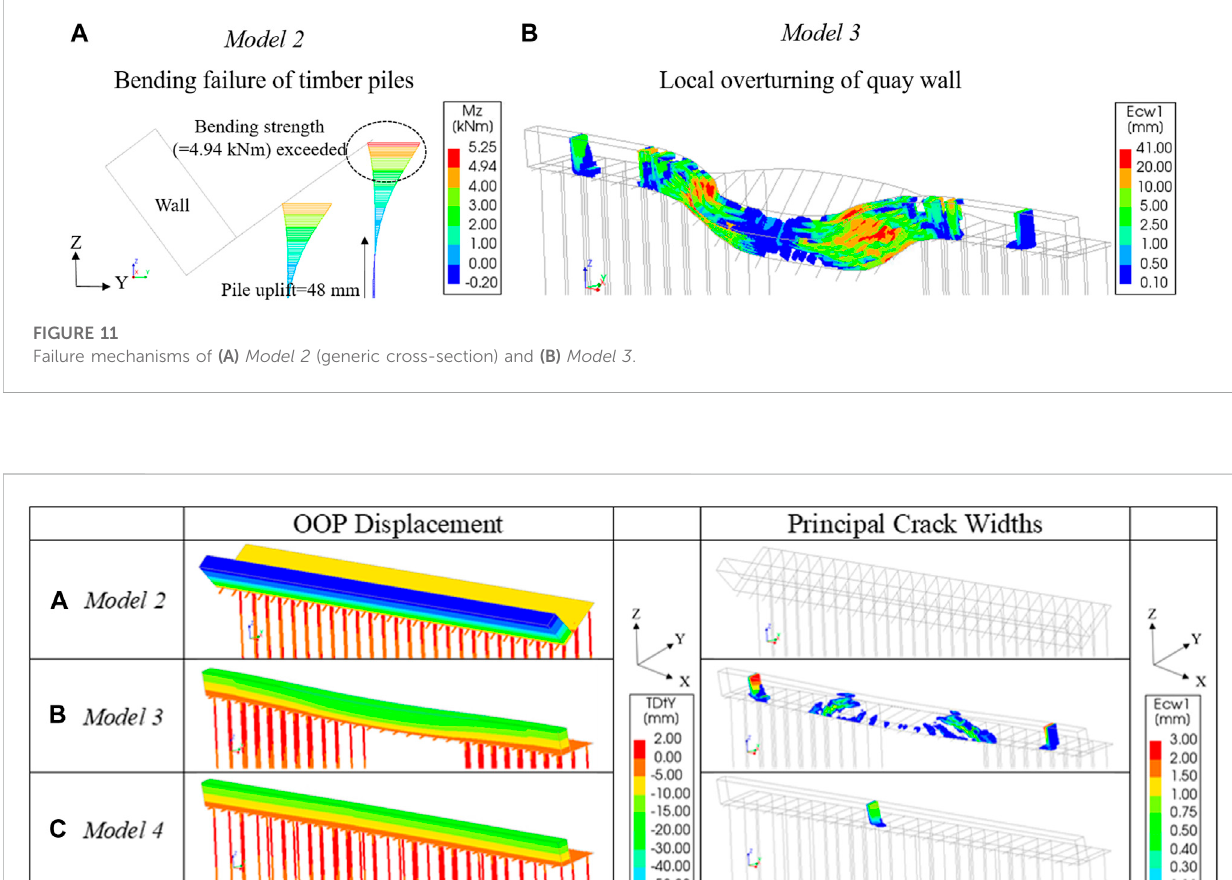
Frontiers in Built